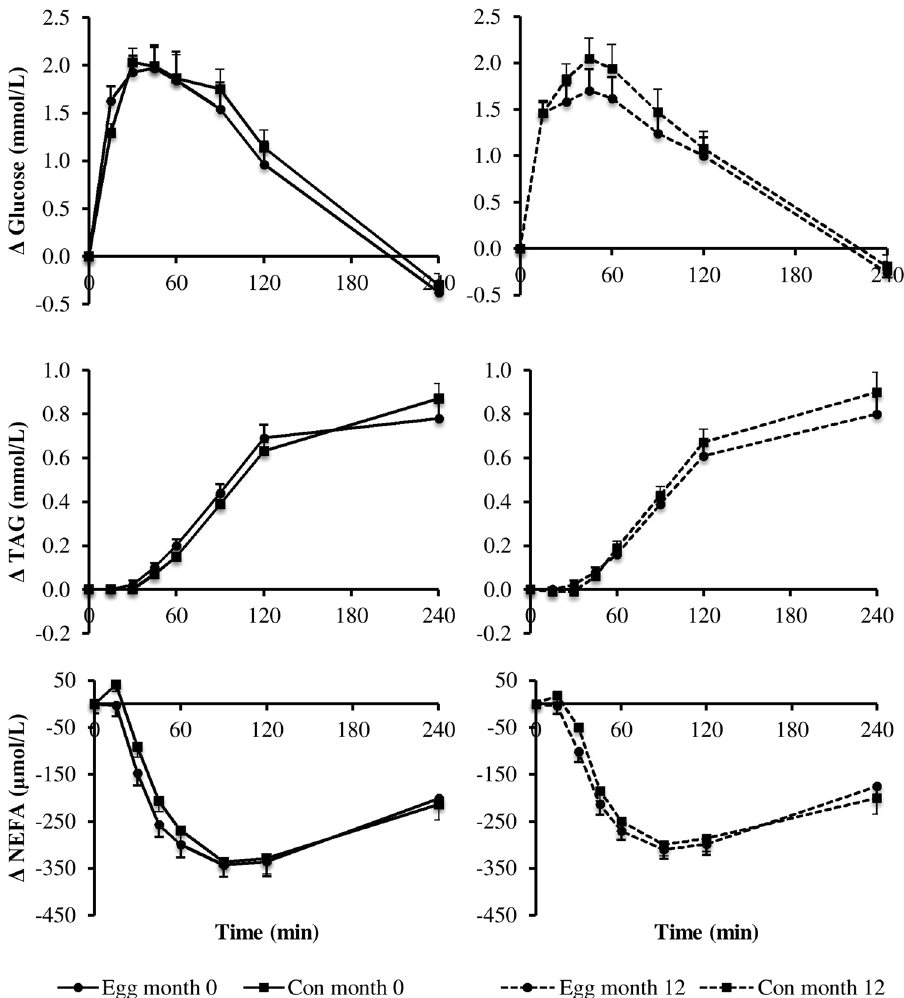
Figure 2. Mean changes ( ± SEM) in plasma glucose, serum triacylglycerol (TAG) and non-esterified fatty acid (NEFA) concentrations following a mixed meal at the start of intervention (month 0) and at the end of intervention (month 12) in a parallel study in subjects with early signs of macular degeneration. Analyses were performed in 45 subjects in the Egg group and 43 subjects in the Con group. Differences between Egg and Con groups were analyzed using Linear Mixed Models. There were no significant meal × time interactions for NEFA, TAG and glucose. Time effects were P < 0.05 for NEFA and glucose. No effects of intervention were